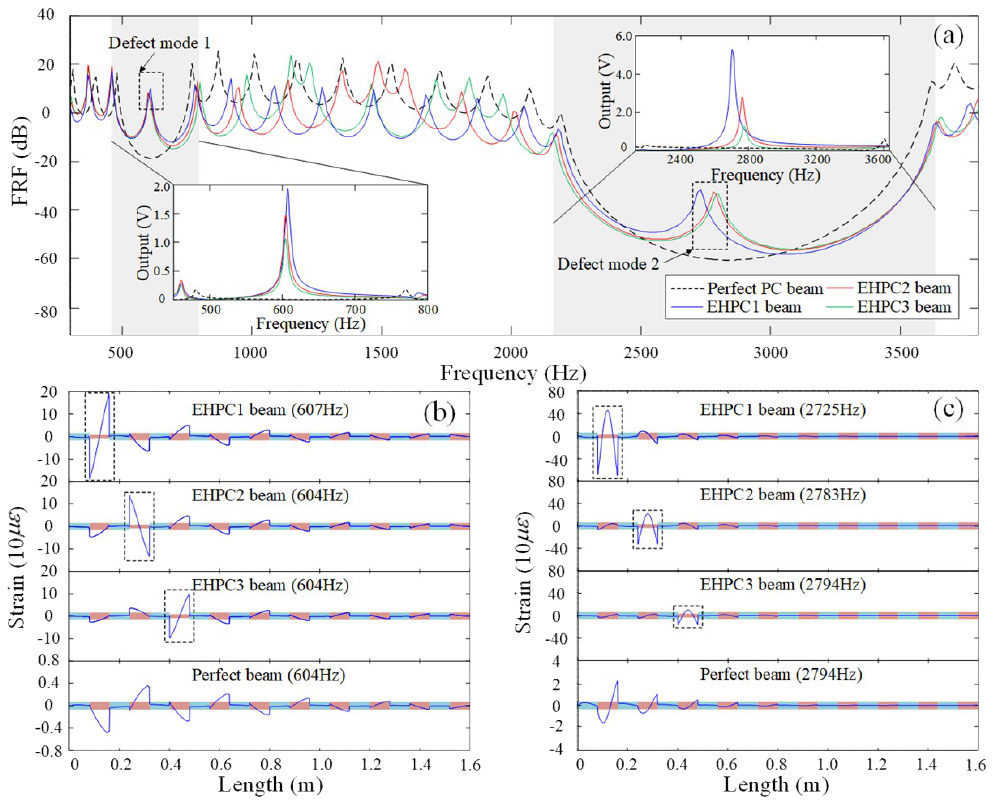
Figure 2. ( a ) Displacement transmission of the three PC beams and simulated output voltage in the band gaps. ( b ) Full-field strain distribution at the frequency of the first defect mode of the defect and perfect PC beam. ( c ) Full-field strain distribution at the frequency of the second defect mode of the defect and perfect PC beam.